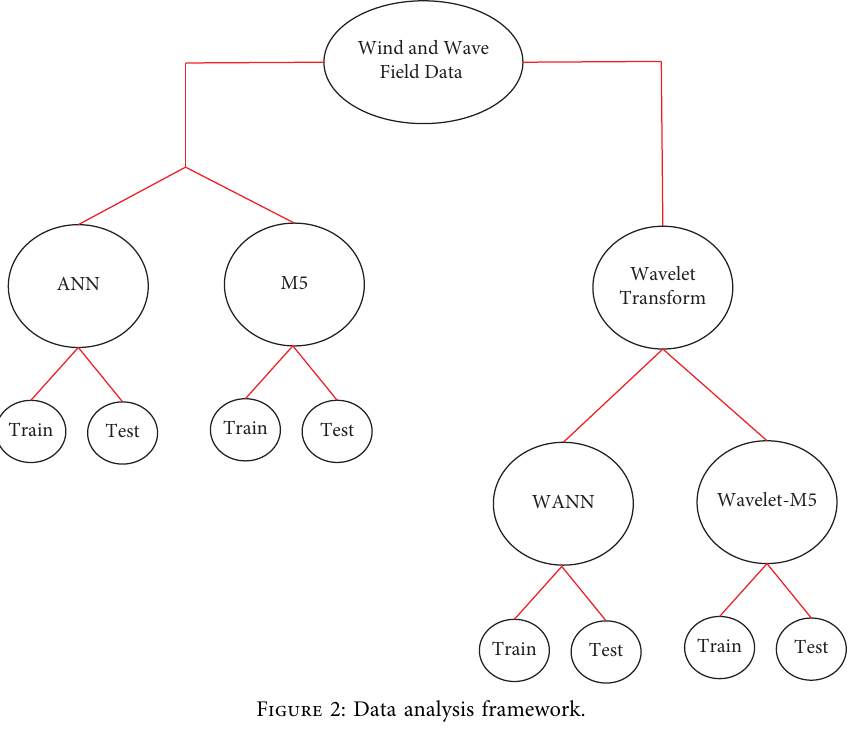
Figure 2: Data analysis framework.